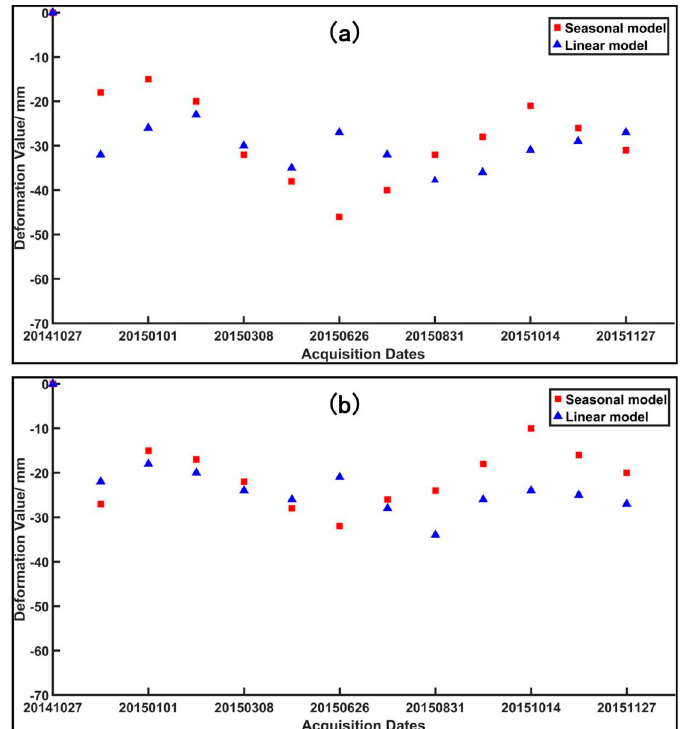
Figure 17. Time series deformation of feature point D, E ( x axis defines the acquisition data of TerraSAR-X images, y axis defines the deformation values); ( a ) Point D; ( b ) Point E.